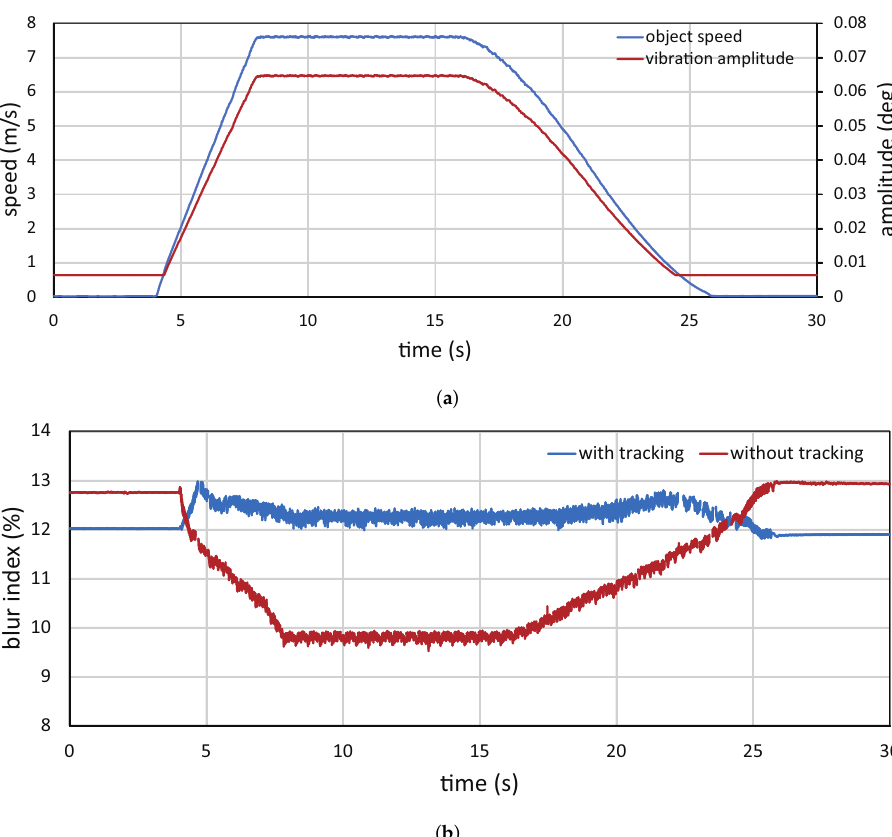
Figure 19. Experimental results for a checkered pattern moving at variable speeds: ( a ) object speed and vibration amplitude of resonant mirror; ( b ) blur indexes λ edge